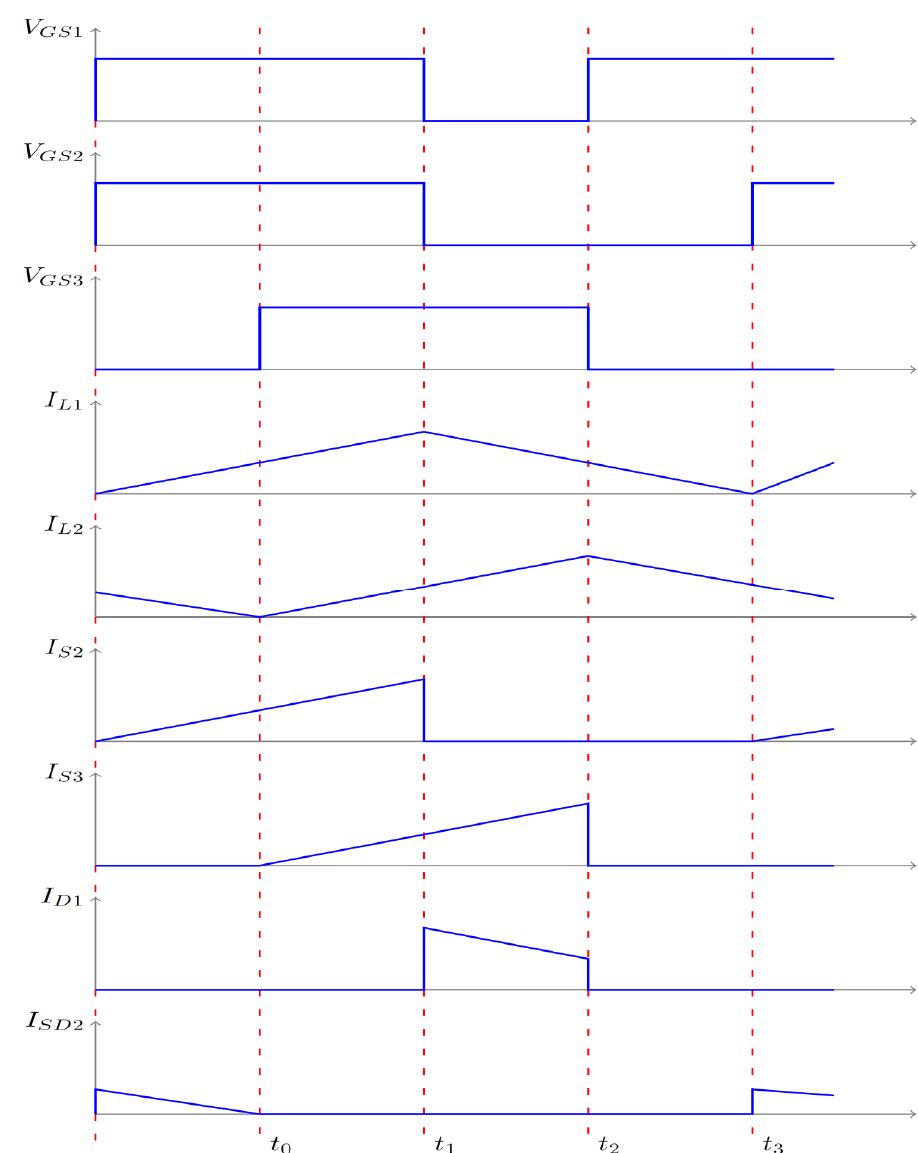
Figure 3. Mode Wave Form for ESS Discharging Domain.